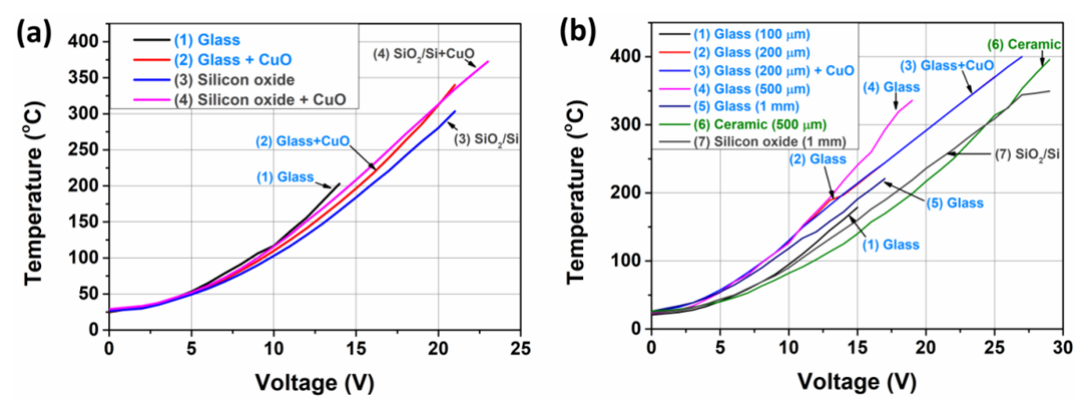
Figure 12. (a) Comparative graph of temperature dependence versus voltage of micro- heaters by vacuum deposition process on glass and silicon oxide substrates without nanostructures deposited film and with the CuO nanostructures deposited film and with gold contacts; (b) Comparative graph of temperature dependence versus voltage of